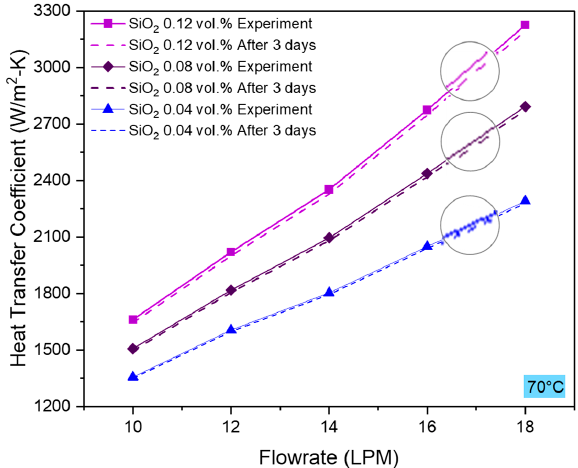
Figure 12. Experimental repeatability test results of the heat transfer coefficient performed after three days of initial experimentation. Nanomaterials 2020 , 10 , x FOR PEER REVIEW